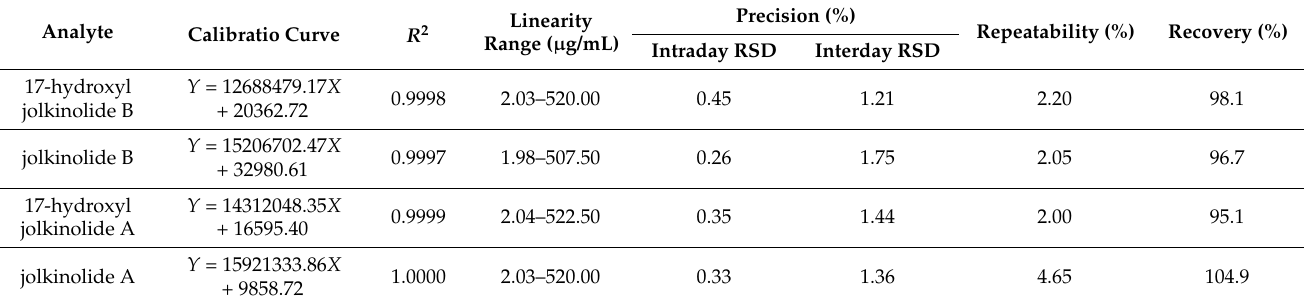
Figure 4. UPLC-UV chromatogram of the four ent-abietane diterpenoids. Table 3. Regression data, precision, repeatability and recovery for the four compounds.